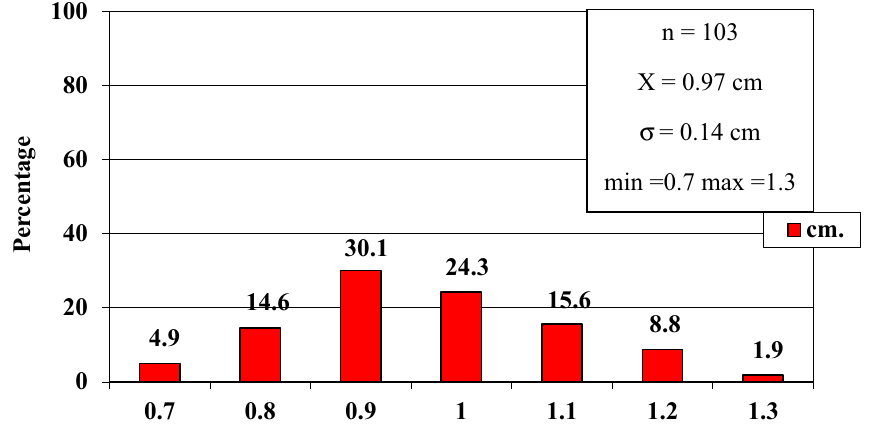
Figure 1. Diameter of the common carotid artery. cm. centimetre, n sample size, X mean, σ standard deviation, min minimum value and max maximum